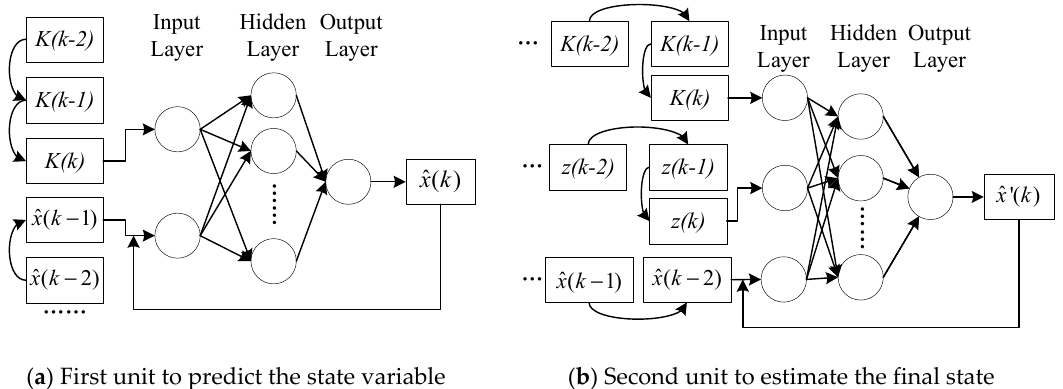
Figure 3. Concrete structures of the two neuro units in the proposed Kalman filter.